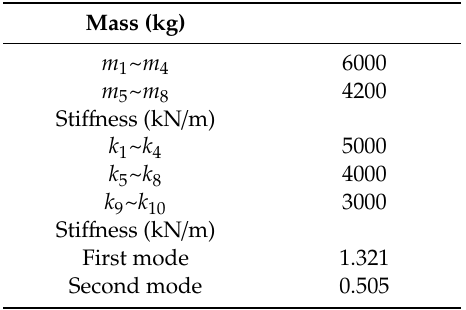
Table 4. Structure properties of the 10-DOF